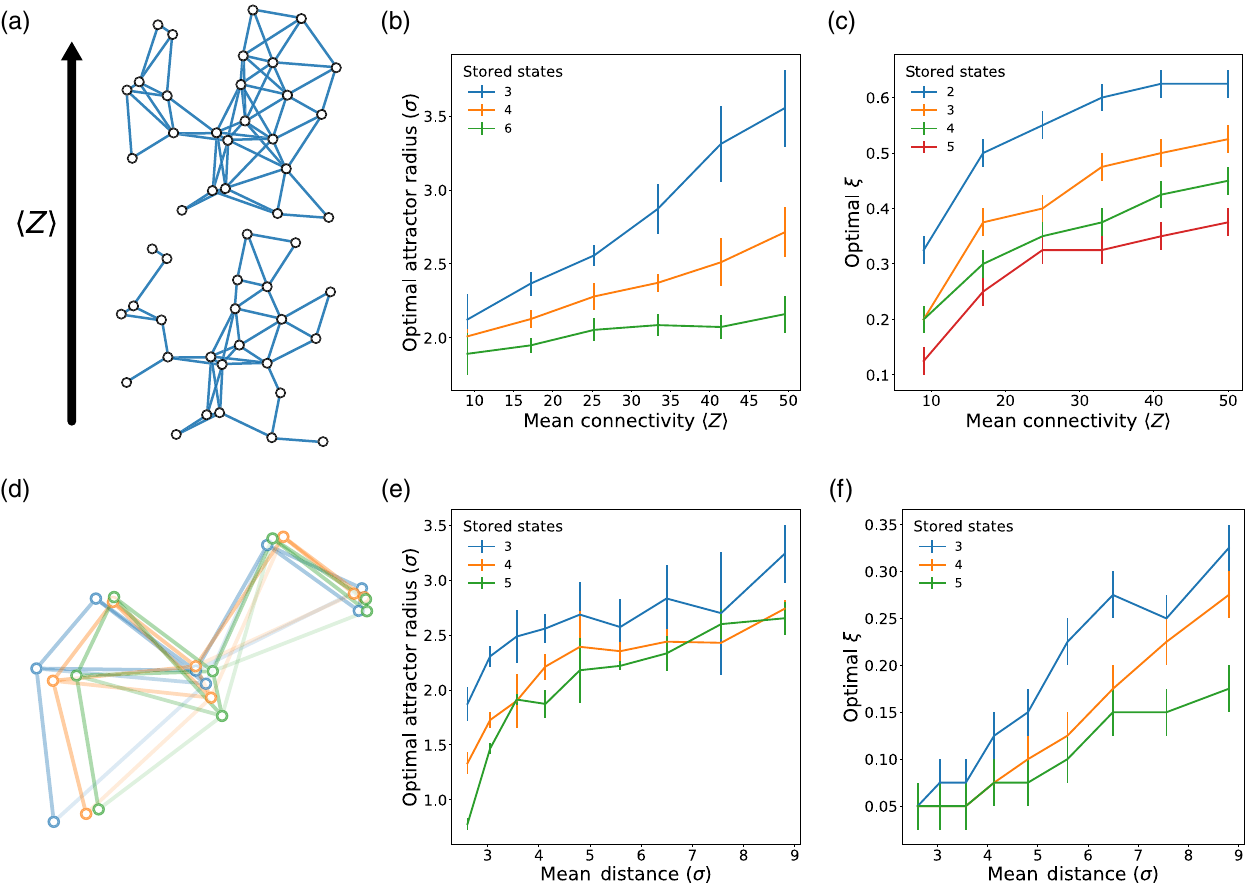
FIG. 11. Effects of node connectivity and state similarity on the quality of encoding the stored states. (a) – (c) Connectivity between nodes h Z i increases with the effective connection radius R . We find that the more internally connected a state is, the larger its attractor size, and higher the optimal value of the nonlinearity parameter ξ ( N ¼ 100 , σ ¼ 5 × 10 − 3 L ). (d) – (f) Trying to store similar states is more difficult than random states. When the mean distance between nodes in successive states is small, attractor ’ s basin is also small, and successful encoding requires small values of ξ and flat potentials ( N ¼ 100 , σ ¼ 5 × 10 − 3 L ). Results averaged over six simulations of random continual learning